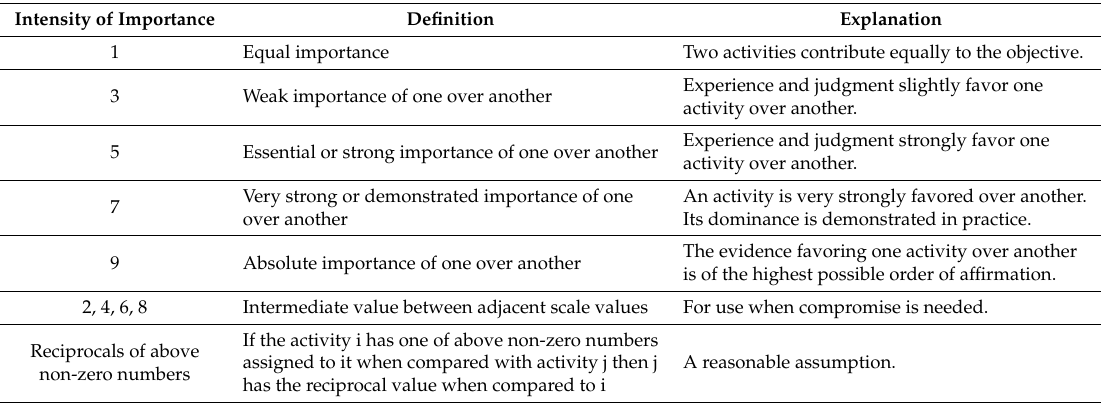
Table 1. The analytic hierarchy